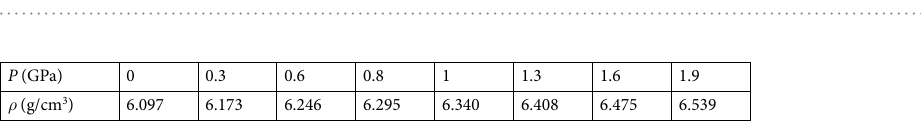
Figure 5. Schematic illustration of the melting of liquid gallium. Ga I rearrange to form locally denser Voronoi polyhedra to get sufficient free volume between the Voronoi polyhedra. Liquid gallium, Ga-II and Ga-III share the similar motifs.